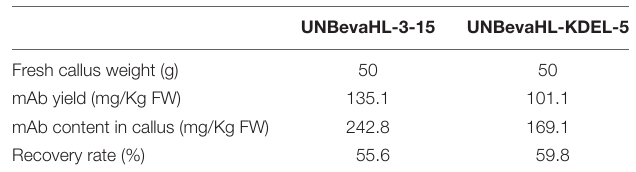
TABLE 1 | Recovery of Bevacizumab mAb expressed in transgenic rice